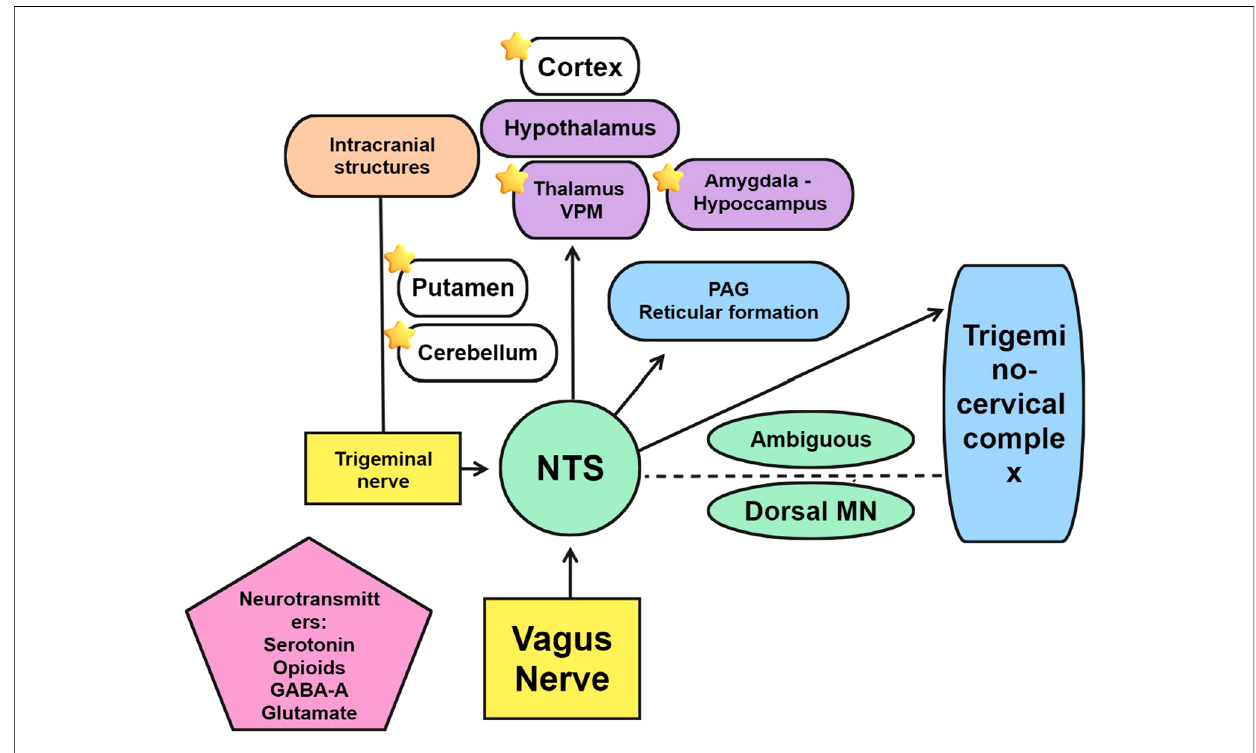
FIGURE 2 Structures and neurotransmitters involved in the mechanism of action of vagal nerve stimulation. Stars indicate changes in regional brain fl